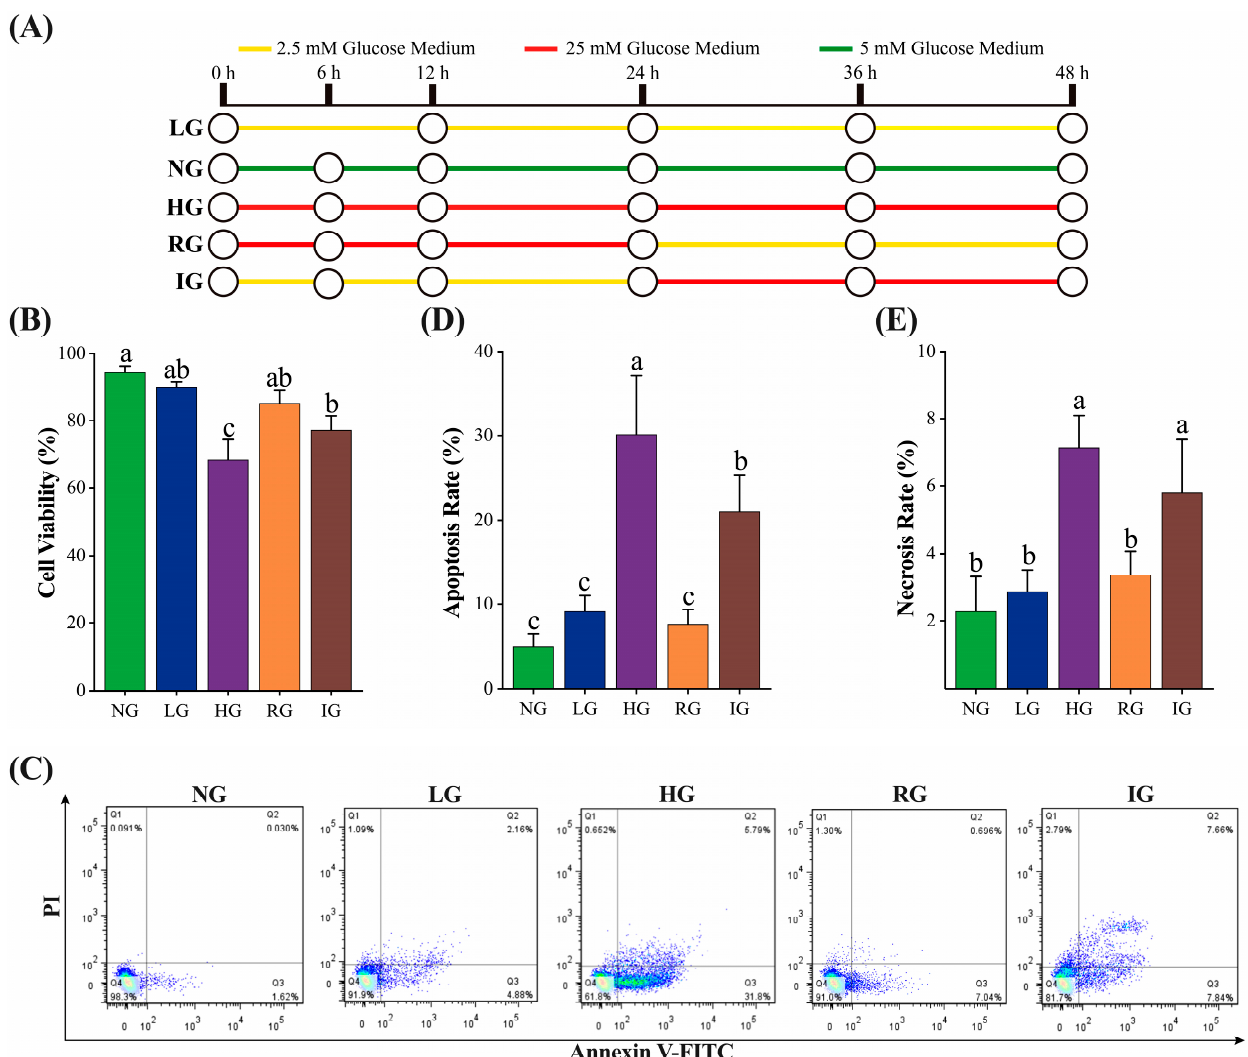
Figure 1. The effects of abnormal glucose on the viability of cultured MDBK cells. ( A ) Schematic diagram of experimental design; ( B , D , E ) the effects of abnormal glucose on the cell viability, apoptosis rate, and necrosis rate of the cultured MDBK cells, respectively. ( C ) The flow cytometry results of the annexin V-FITC/PI assay. All experiments were repeated at least 3 times, and the data were presented using mean ± SD. Histograms with different superscript letters (a–c) are significantly different (Waller–Duncan, p < 0.05).